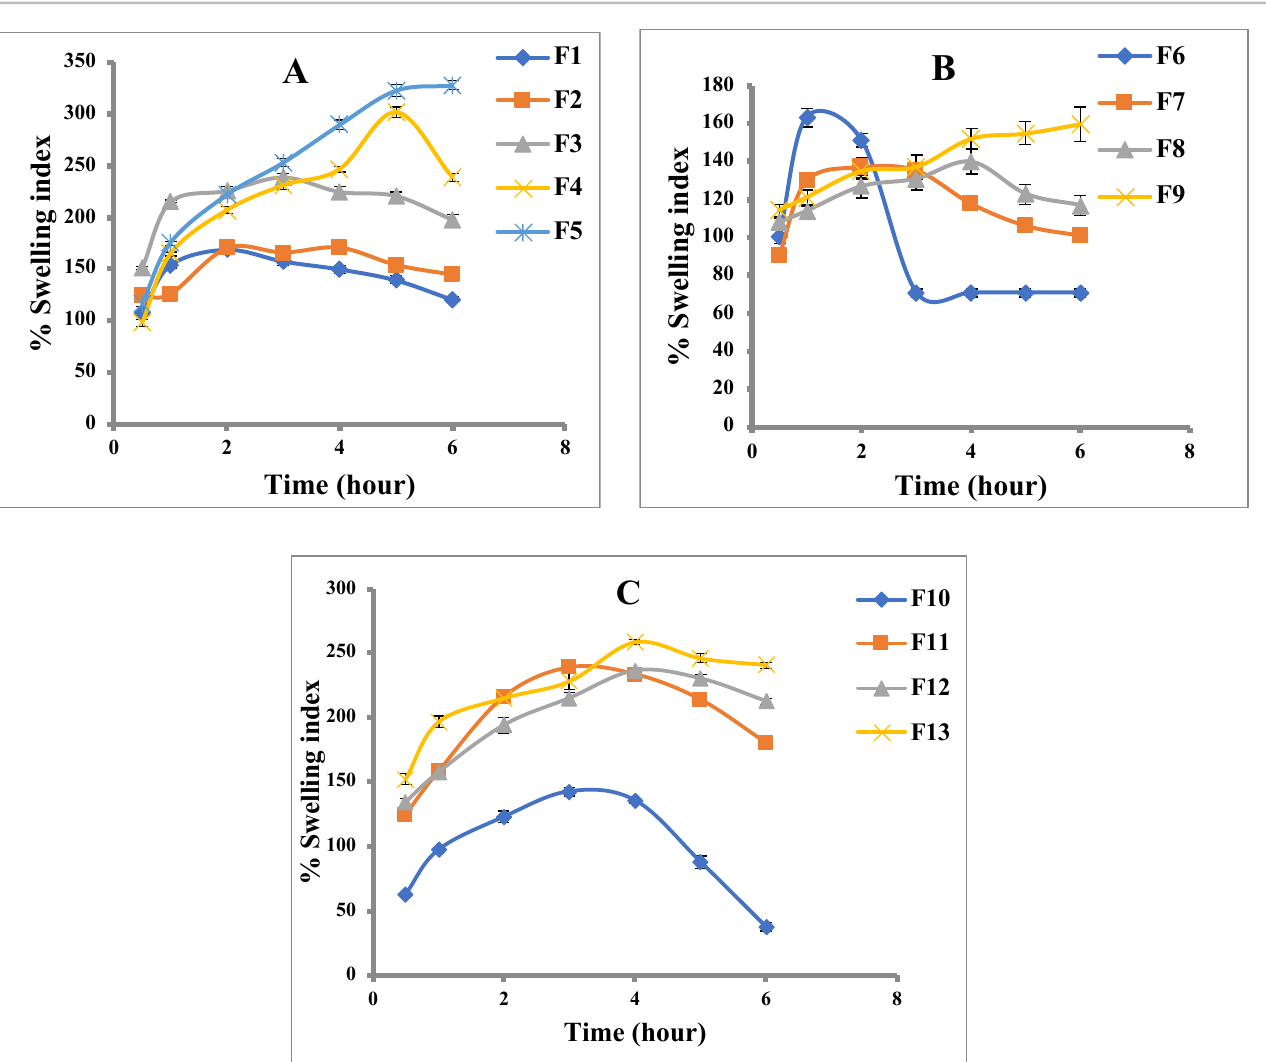
FIGURE 5 - (A-C) Swelling behavior of press-coated tablets containing PEO WSR 110, Carbopol 71G and HPMC K4M